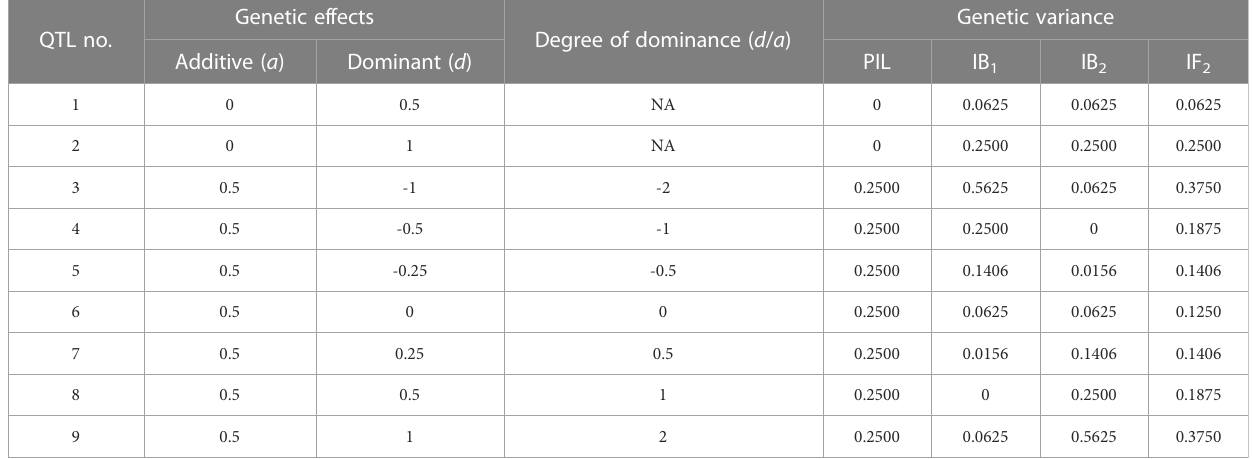
TABLE 4 Genetic effects and variances of the pre-de fi ned QTLs in simulation experiment I.